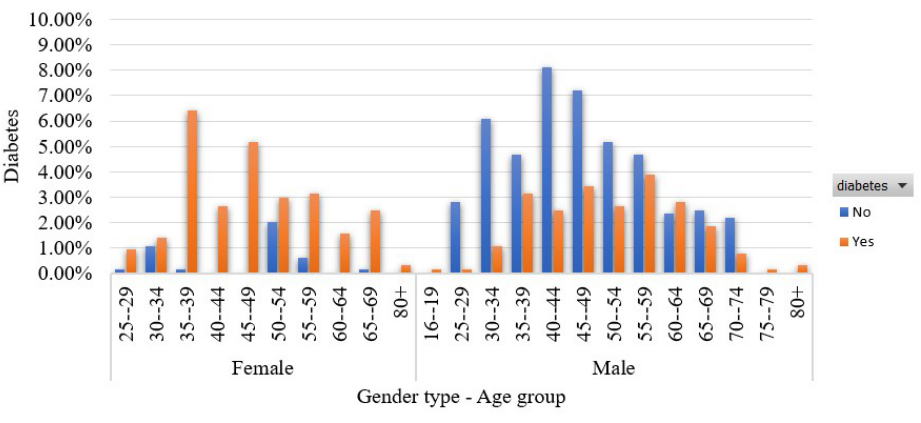
Figure 1. Participants’ distribution in terms of the age group and gender.